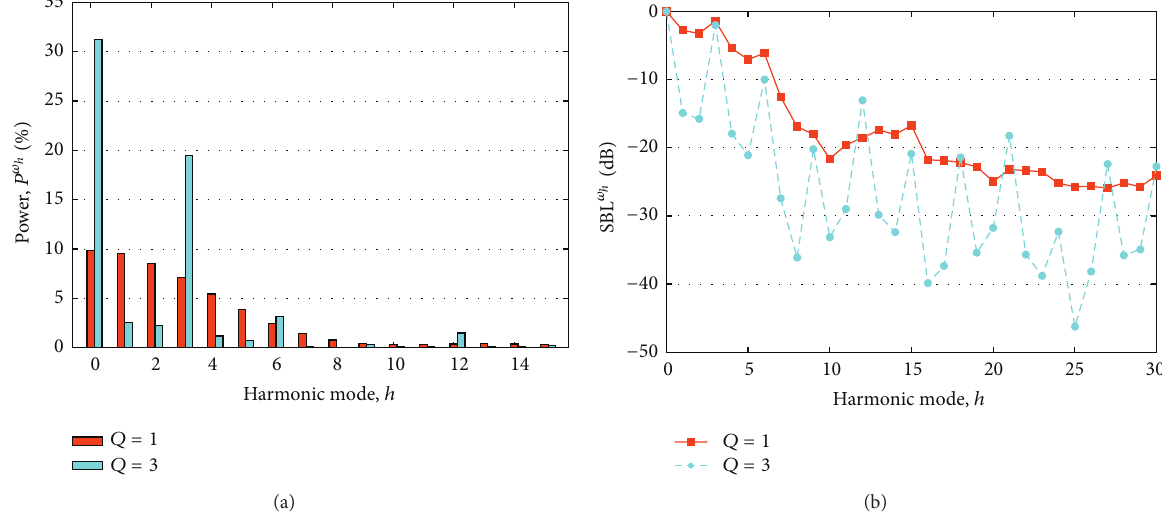
Figure 7: Comparative assessment—single-pulse waveform, 𝑄 = 1 versus multipulse waveform, 𝑄 = 3 ( 𝑁 = 16 ; 𝑑 = 𝜆/2 ; 𝜃 𝜔 0 = 90 ∘ ; 𝜃 𝜔 3 = 120 ∘ )—plot of (a) the power associated with the harmonic radiations in percentage on the total power and (b) the sideband level associated with the harmonic